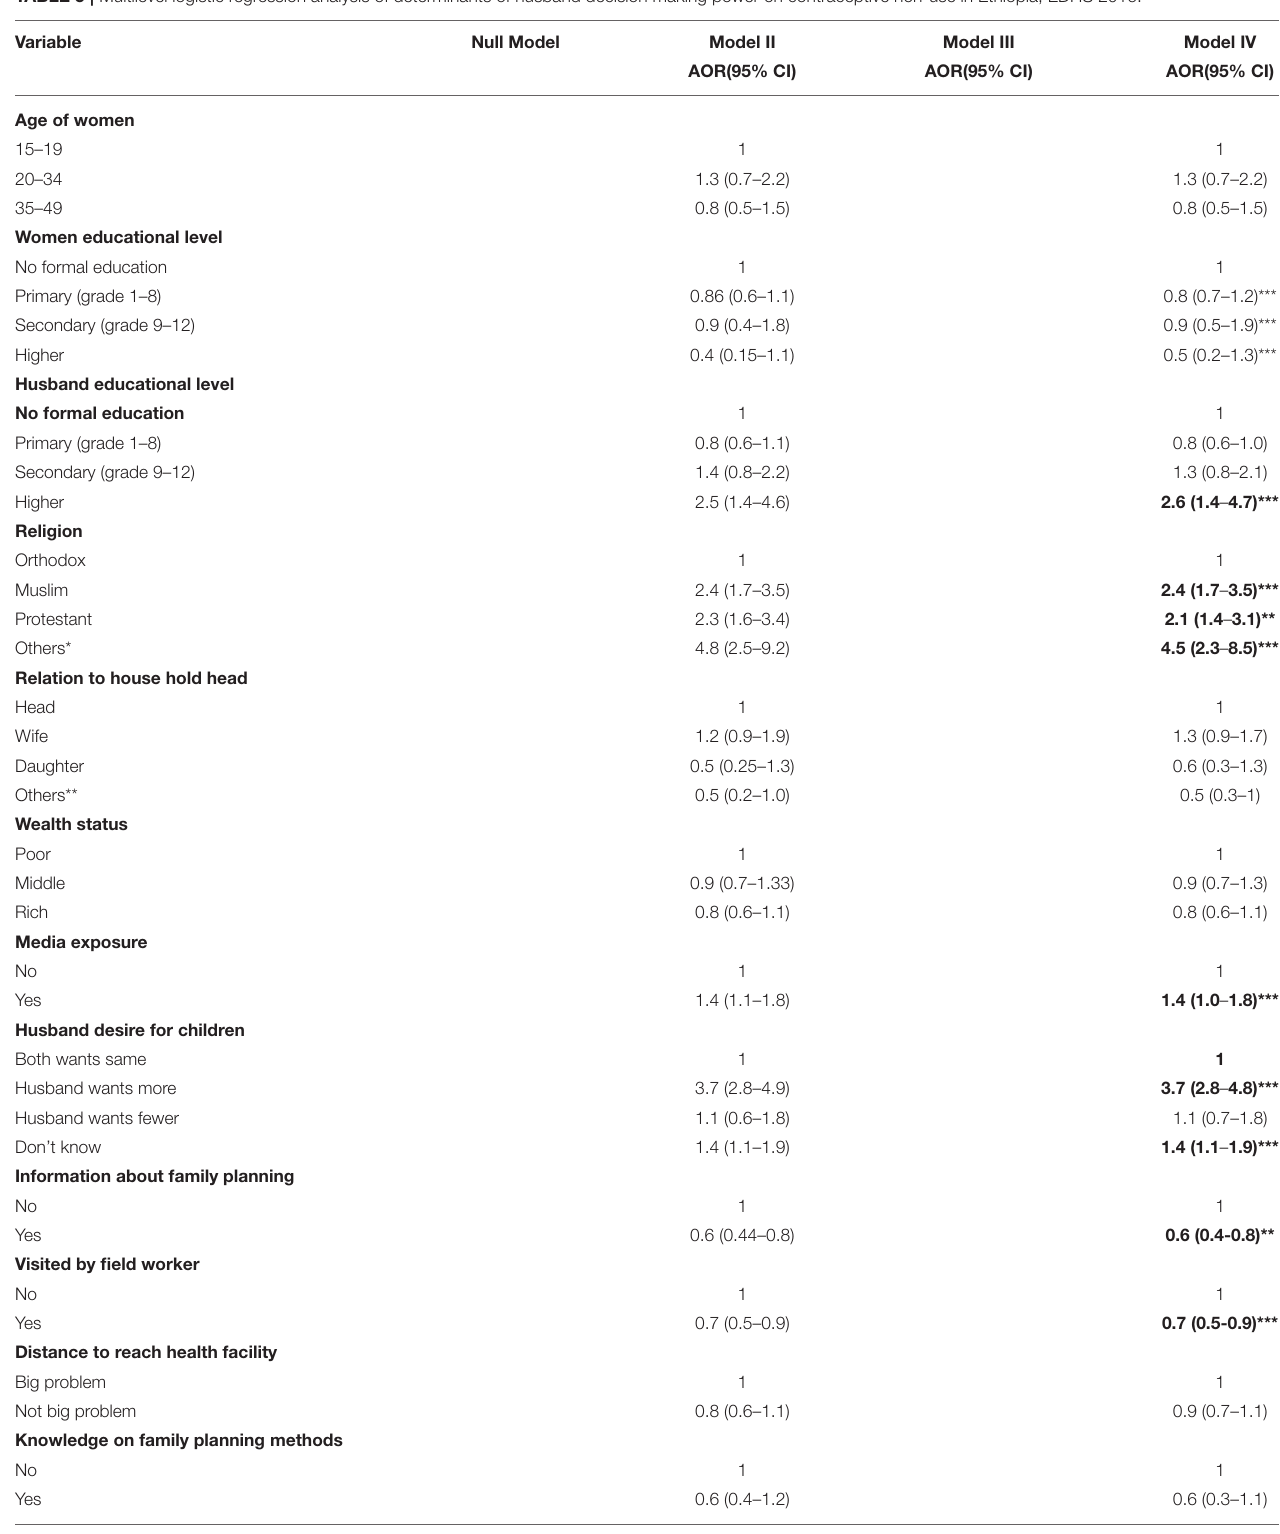
TABLE 5 | Multilevel logistic regression analysis of determinants of husband decision making power on contraceptive non-use in Ethiopia, EDHS